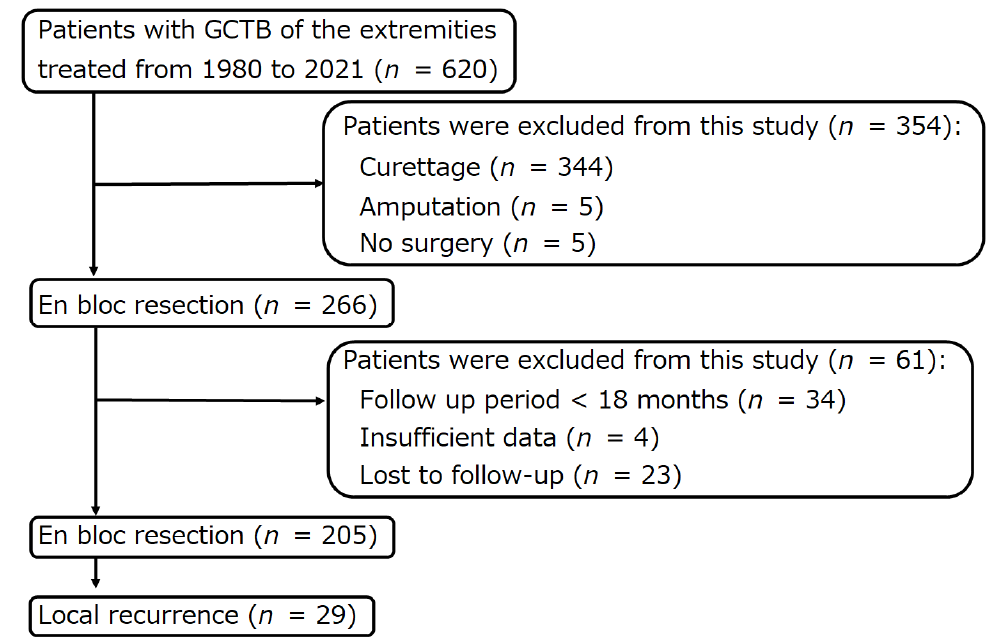
Figure 1. Flow diagram of patients with giant cell tumors of bones of the extremities, who were treated at three institutions between 1980 and 2021.